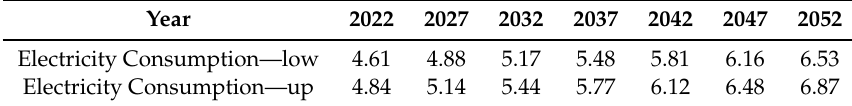
Table 4. BASE scenario electricity consumption bounds for Rail Vehicles (PJ).